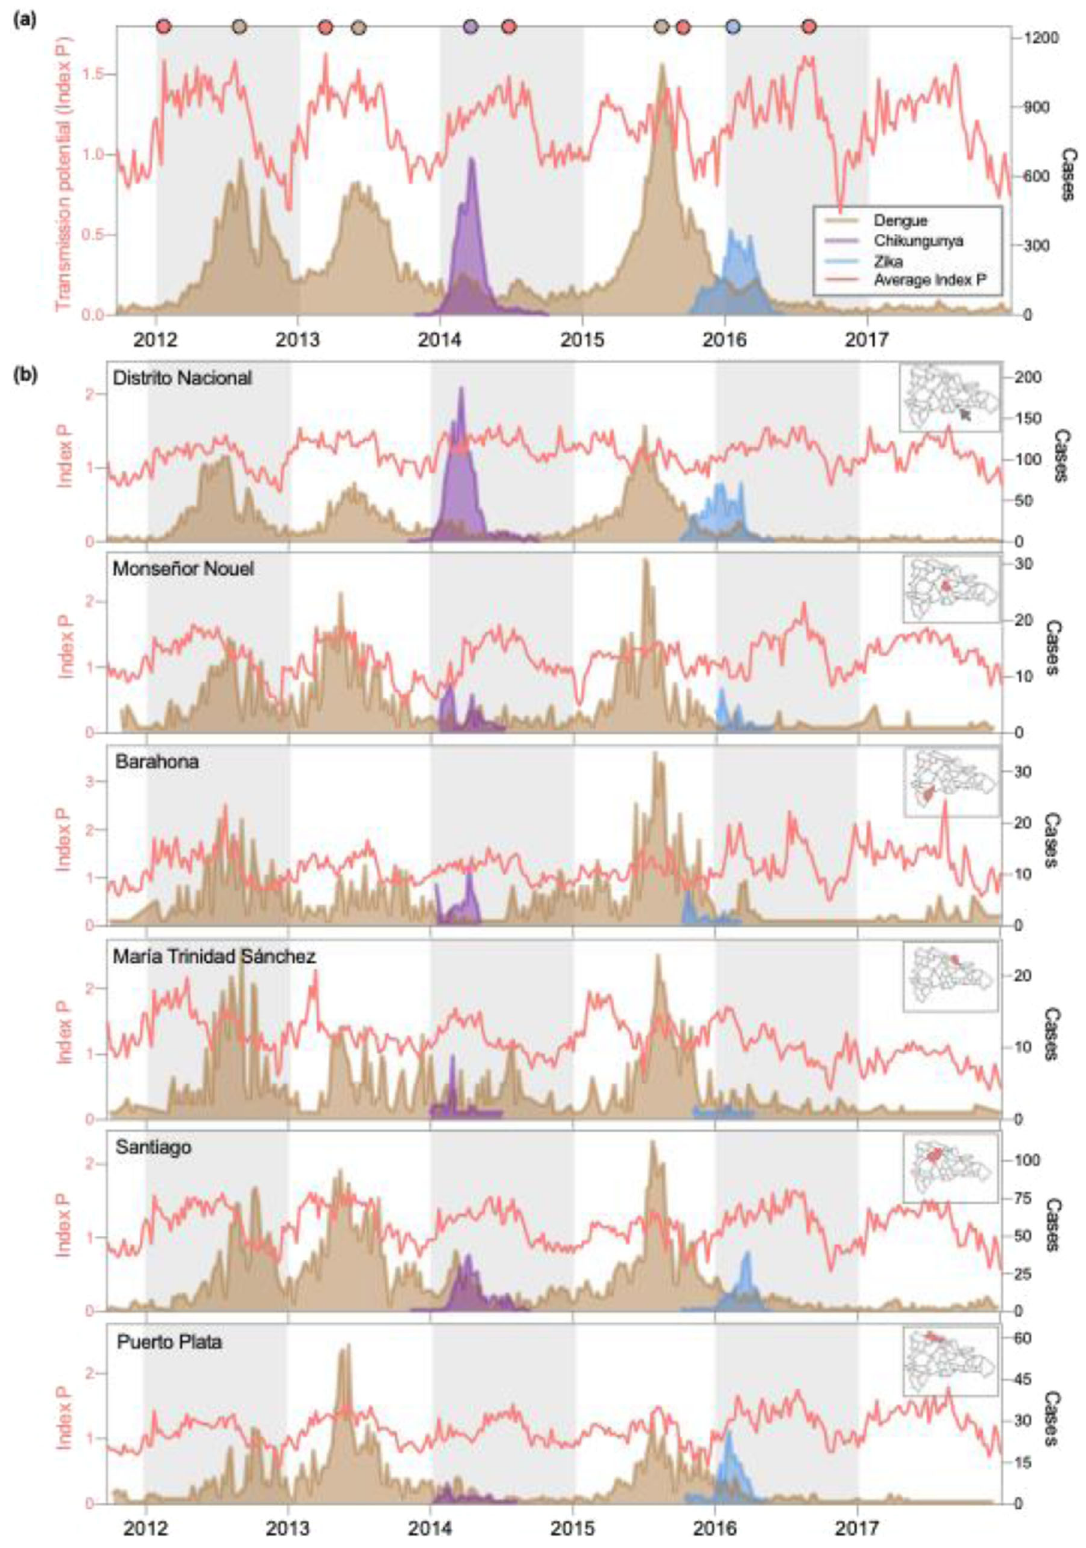
Fig. 2 Emerging disease outbreaks occurred during periods of suboptimal climate. a Average weekly transmission potential ( Index P ) and nationally reported cases. Index P describes the reproductive potential of an individual female Aedes mosquito, meaning its absolute value should be interpreted biologically rather than epidemiologically. Relative fl uctuations in Index P re fl ect seasonal changes in the expected rate of mosquito-borne virus transmission. The peaks of each curve during each season are denoted as circles on the top x axis. b Index P and reported cases for six provinces. Temperature and humidity data were retrieved from the National Meteorology Of fi ce (ONAMET) database (saip.gob.do) for Distrito Nacional, Barahona, Puerto Plata, María Trinidad Sánchez, and Santiago. Hourly climatological data for Monseñor Nouel were obtained from Open Weather Map (openweathermap.org). Reported cases of dengue, chikungunya, and Zika were organized by province based on the individual ’ s place of residence. NATURE COMMUNICATIONS| (2021) 12:151